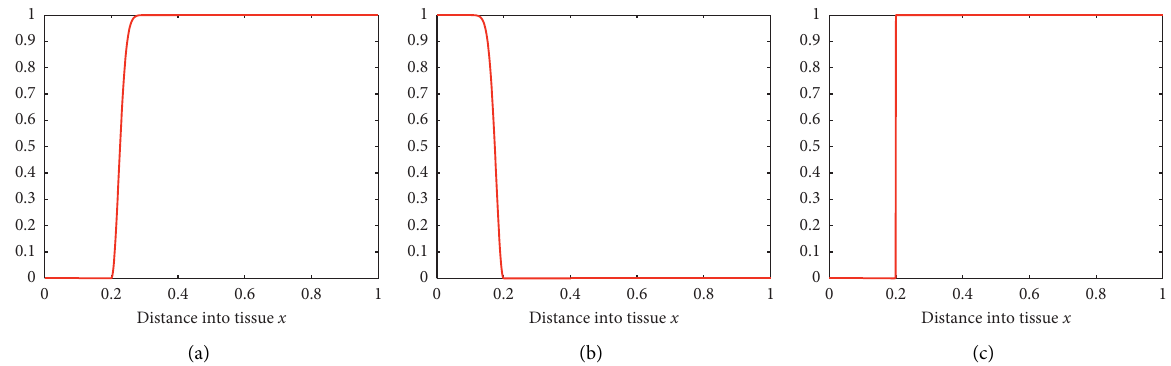
Figure 1: The initial position of the effector cell, the cancer cell, and the IL-2 compound concentrations. (a) Concentration of effector cells, u ( x ). (b) Concentration of cervical cancer cells, v ( x ) . (c) Concentration of IL-2, w ( x ) .